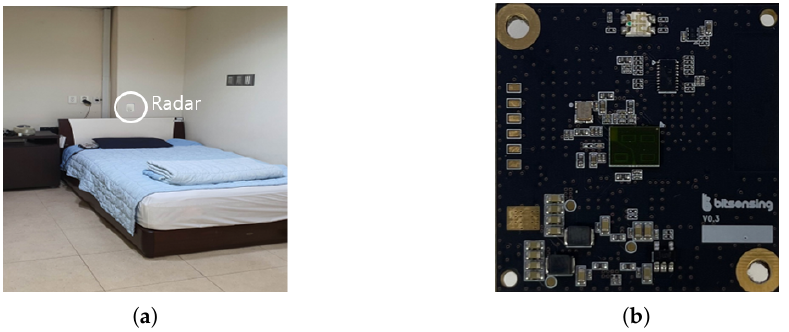
Figure 6. Experimental setup. ( a ) Clinical data acquisition environment. ( b ) Single-channel FMCW